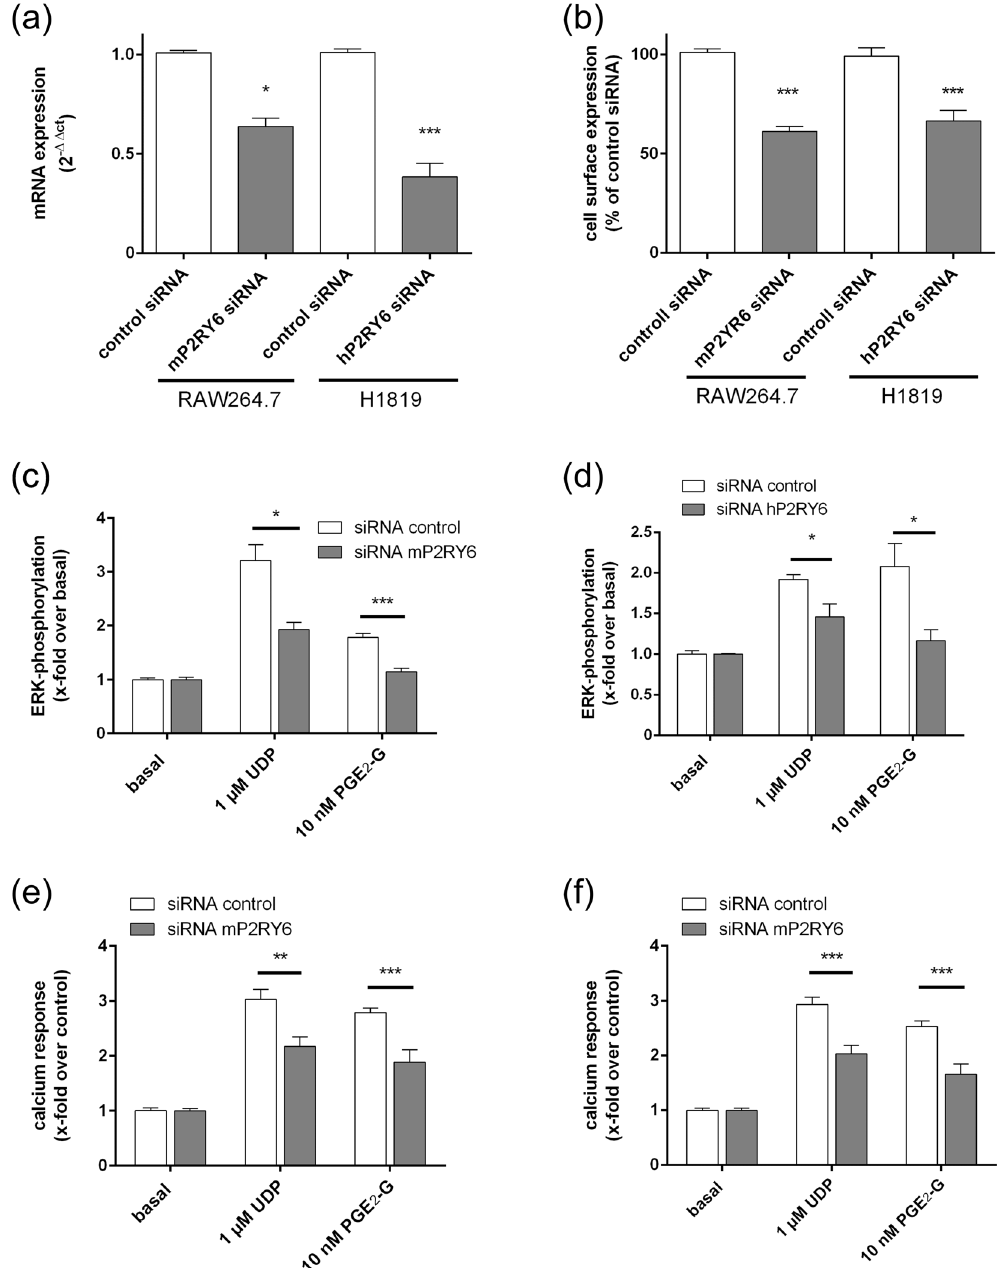
Figure 4. Knock-down of P2Y6 revealed decreased signal transduction of UDP and PGE2-G. ( a ) and ( b ) RAW264.7 and H1819 were transfected with siRNA for mouse and human P2RY6, respectively. (a) mRNA expression levels of P2RY6 were determined ( see Methods ) and were normalized to β 2-microglobulin (C t were 14.6 ± 0.2 and 17.4 ± 0.1 for RAW264.7 and H1819, respectively). Values are given as mean of 2 −ΔΔ Ct ± SEM and statistical analysis was performed according to ref. 58. ( b ) Protein expression levels of P2Y 6 were determined using a cell surface ELISA using an N-terminus-directed anti-P2Y6 specific antibody (see Methods ) and are given as OD at 492 nm. Data are given as means ± SEM of three independent experiments performed in quadruplicates. ( c – f ) siRNA-transfected RAW264.7 ( c , e ) and H1819 ( d , f ) were incubated with the indicated concentrations of UDP and PGE 2 -G, and ERK1/2 phosphorylation ( c , d ) and Ca 2 + mobilization assays ( e , f ) were performed as described. All data are means ± SEM of three independent experiments, each performed in triplicate. * p < 0.05, ** p < 0.01, *** p < 0.001 (paired Student’s t